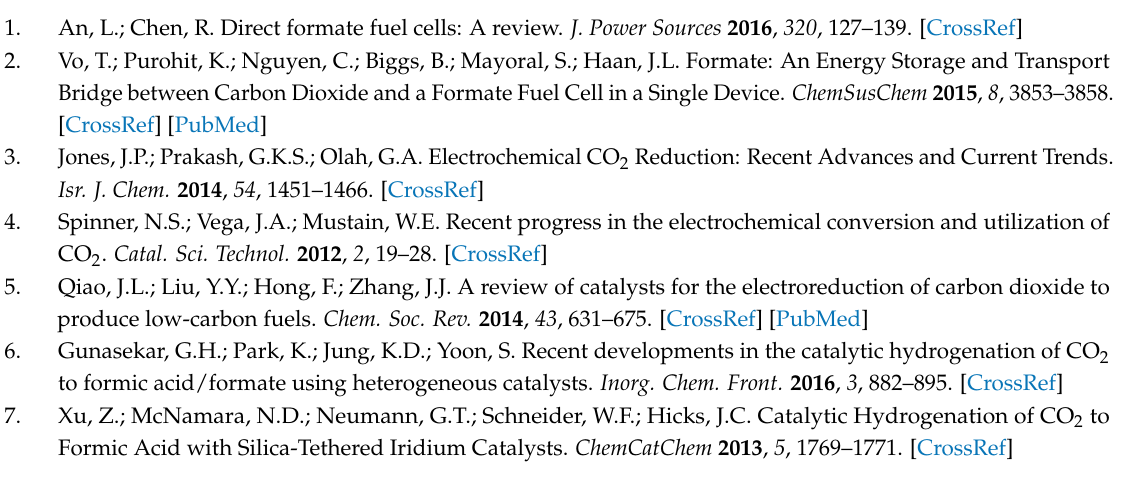
Section S1: Description of energy calculations, Figure S1: pVBC-DABCO polymeric structure, Figure S2: 1H NMR spectrum of pVBC, Figure S3: TGA analysis, Figure S4: DSC analysis, Table S1: Polymer properties. Acknowledgments: Ente Cassa di Risparmio di Firenze (project EnergyLab). We also thank Roberto Spiniello for performing the TGA/DSC